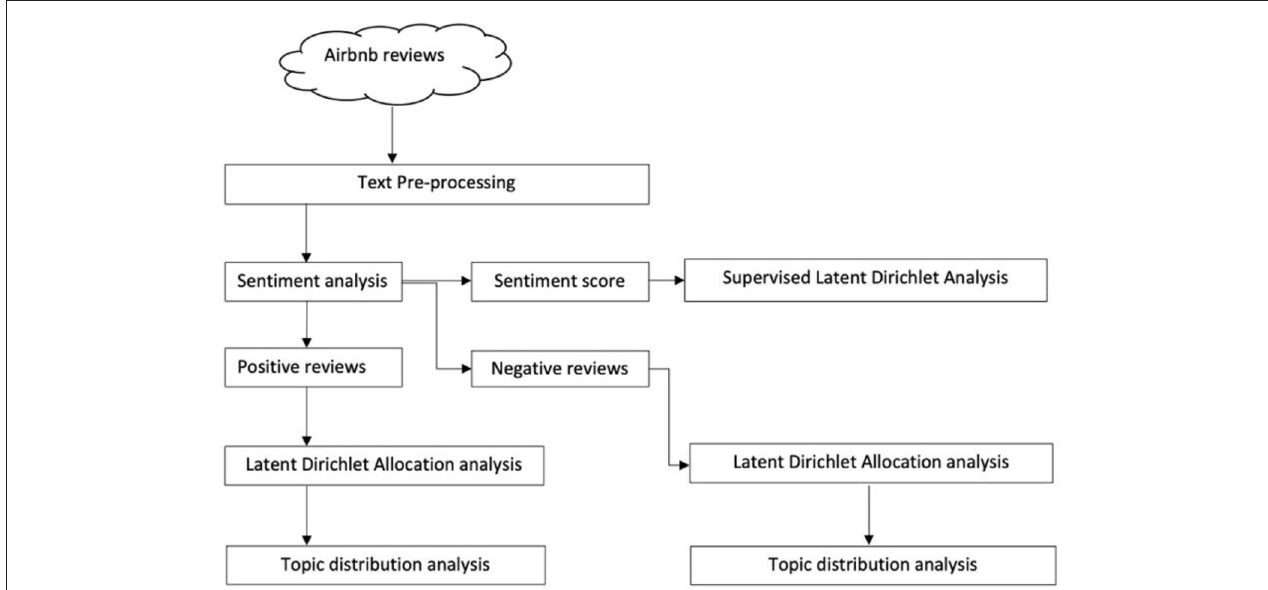
FIGURE 1 | Research framework. Source: created by the authors.